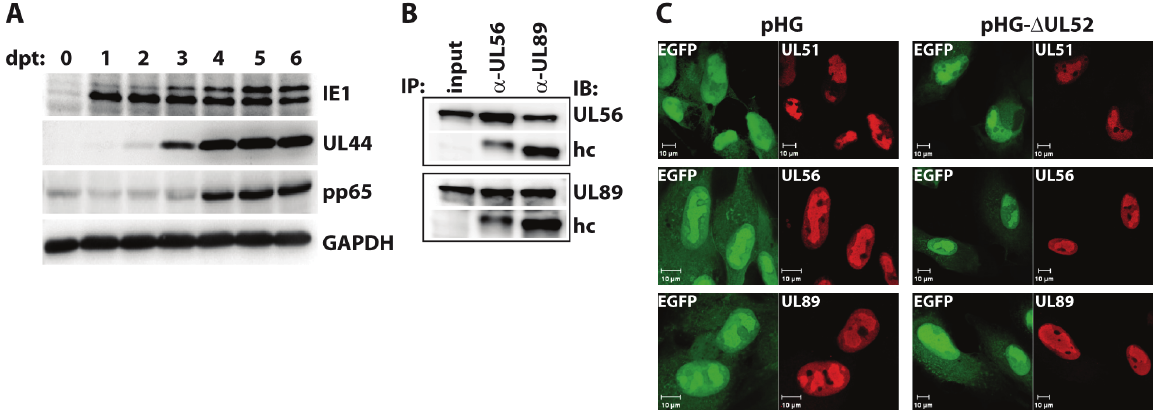
Figure 4. Investigation into RPE-1 cells adenofected with the UL52-deleted genome pHG- Δ 52. ( A ) Transfected cells were harvested on days zero to six post transfection (dpt) and expression of the indicated proteins was analyzed by immunoblotting. Please note that the pp65 antibody exhibits some cross-reactivity with cellular proteins as observed previously [42]; ( B ) Interaction of the terminase subunits UL56 and UL89 in the absence of UL52. RPE-1 cells adenofected with pHG- Δ 52 were subjected to immunoprecipitation with α -UL56 and α -UL89 monoclonal antibodies on day 4 post transfection, followed by immunoblotting using the same antibodies. Input: whole cell lysate before IP, hc: IgG heavy chain; ( C ) Subcellular localization of HCMV terminase subunits in the presence or absence of UL52. RPE-1 cells were adenofected with pHG or pHG- Δ 52 and analyzed on day 4 post transfection by confocal laser scanning microscopy using monoclonal antibodies against UL51, UL56, and